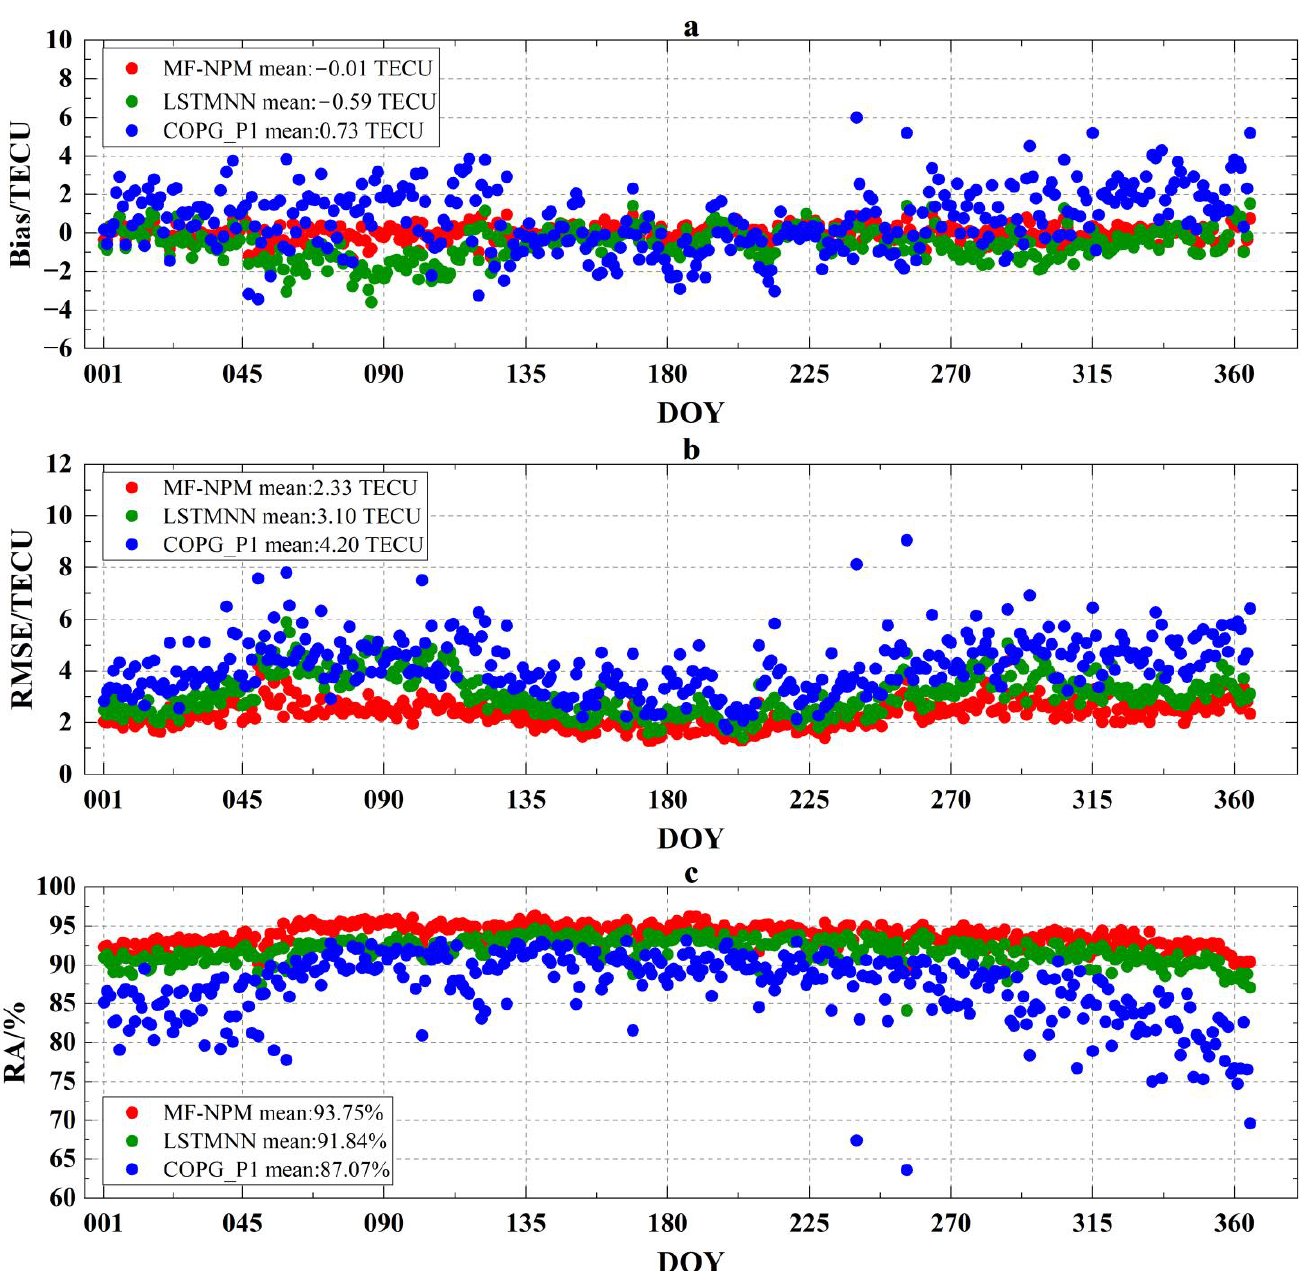
Figure 4. The variations of ( a ) bias, ( b ) RMSE, and ( c ) mean relative error of MF-NPM, LSTMNN, and COPG_P1 respected to IGS in the peak year of solar activity